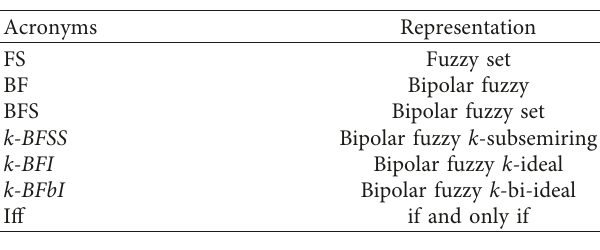
Table 1: List of acronyms.